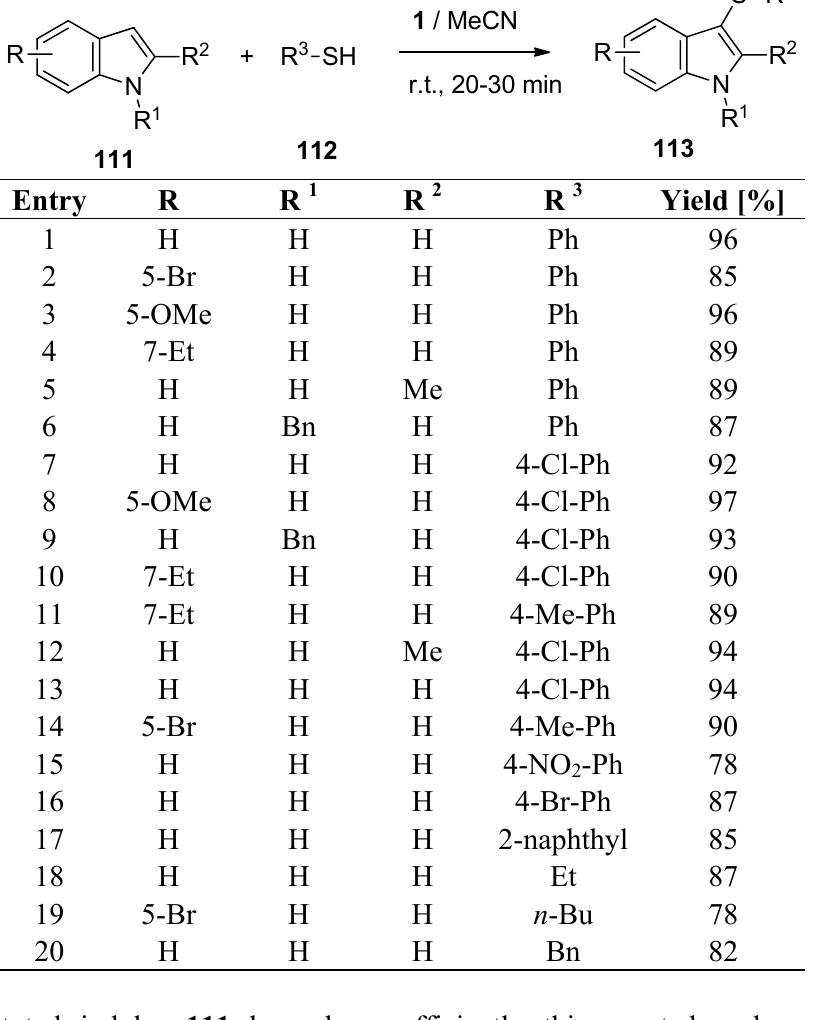
mediated synthesis of 4